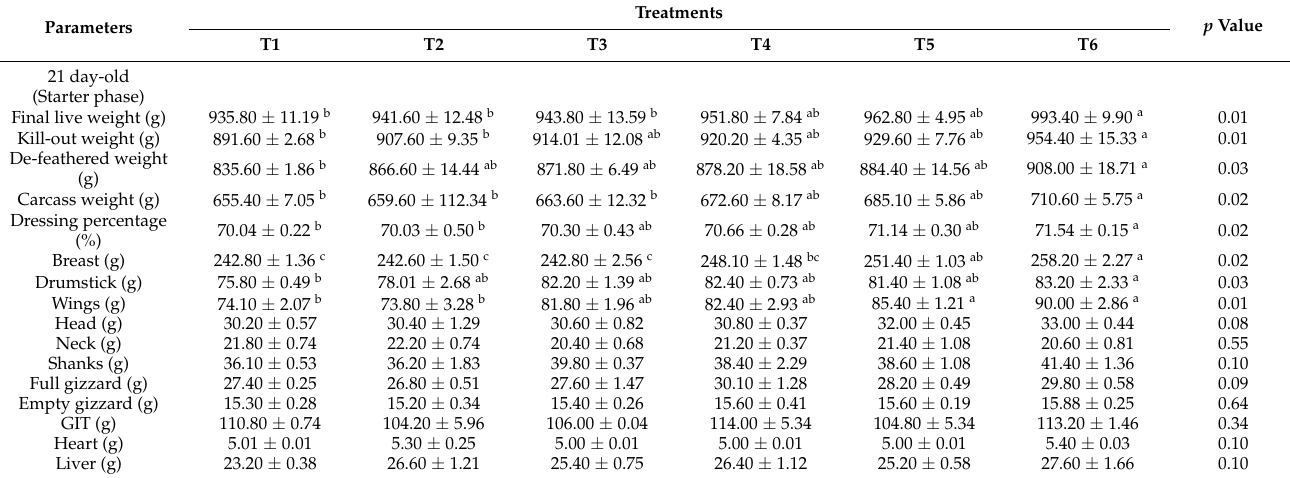
Table 6. Effect of Y. schidigera supplementation on the carcass characteristics of broilers on day 21.